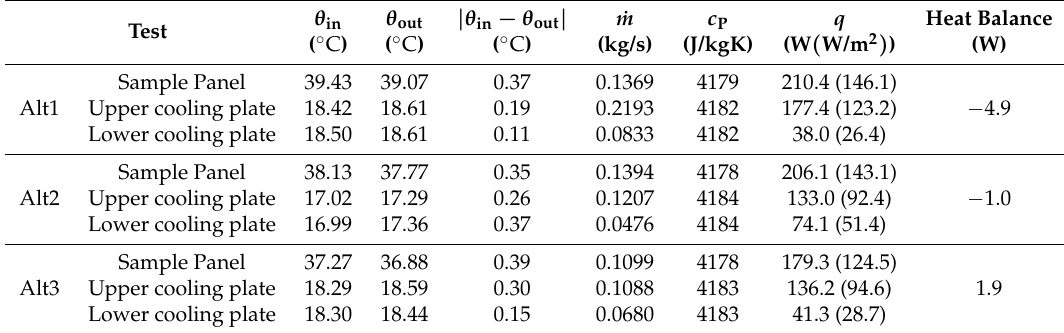
Table 8. Experimental result of the supply–return water temperature and flow rate and of the heat balance (additional experiment).